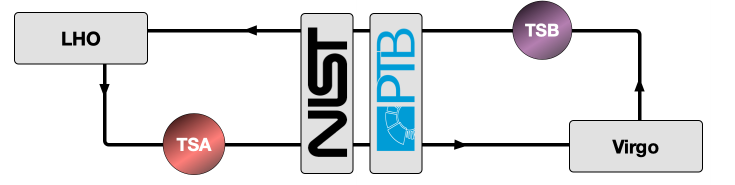
Figure 6. Simplified version of the scheme shown in Figure 4 to be used at the start of the O4 observing run after the NIST:PTB bilateral comparison outlined in Figure 5 is completed. The KAGRA detector is expected to join this scheme later in the observing